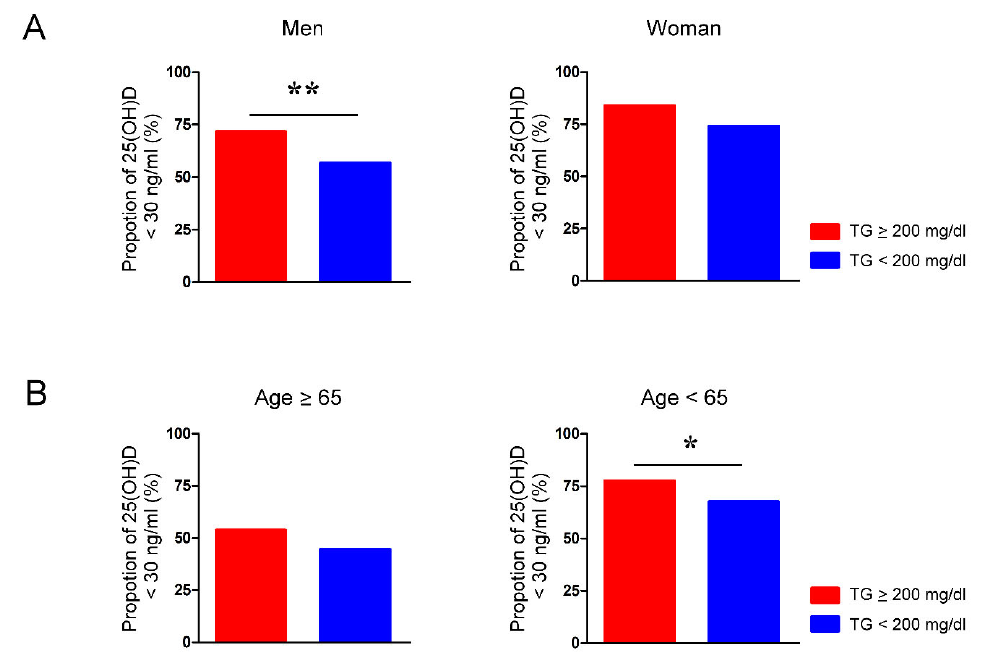
Figure 2. Proportion of vitamin D deficiency in people with and without hypertriglyceridemia is modulated by sex and age. The rate of serum 25-hydroxyvitamin D (25(OH)D) levels below 30 ng/mL in ( A ) men and women and ( B ) individuals aged younger and older than 65 years whose serum levels of triglycerides (TG) were greater or less than 200 mg/dL. * p < 0.05, ** p < 0.01.